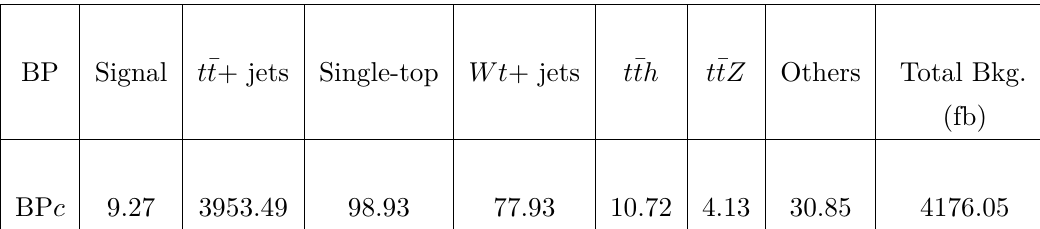
Table 5 . The cross sections (in units of fb) of the signal (BP c ) and different background components for 3 b 1 ‘ process after selection cuts at